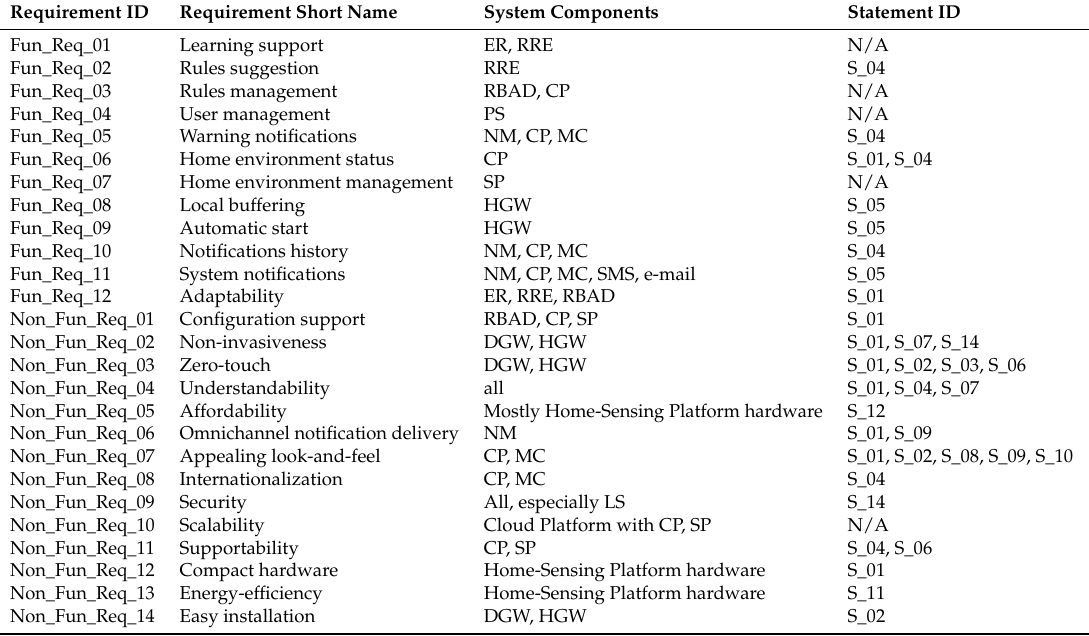
Table 5. Mapping of system requirements to system components and related